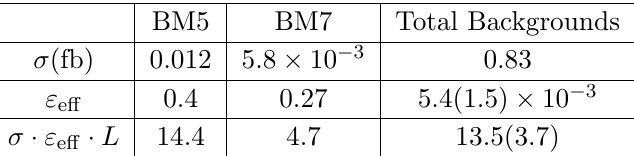
Table 2 . The signal benchmarks, BM5 and BM7 are displayed at the (cid:12)rst two columns and the total background is displayed in the last column. In the (cid:12)rst row, we show the cross sections, in fb, after the basic selection discussed in the text.The second and third rows show the cut e(cid:14)ciencies and the number of events after optimization assuming 3 ab (cid:0) 1 . The numbers in parenthesis in the last column represents the backgrounds for the cuts that maximize the BM7